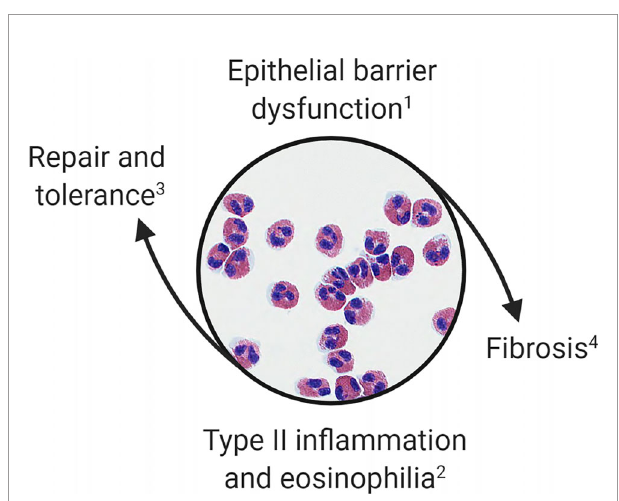
FIGURE 1 | Proposed model of esophageal eosinophilia. Eosinophils are initially recruited to the esophagus to restore barrier function. When in fl ammatory and remodeling responses become dysregulated eosinophils contribute to type 2 in fl ammation, worsening of barrier integrity, and fi brosis. This paradigm allows for categorization of (1) patients with IgE-mediated food allergy or subclinical barrier dysfunction; (2) OIT patients, EoEe1, and EoEe2 representing asymptomatic, mild or severe phases of the in fl ammatory response; (3) OIT patients who successfully develop